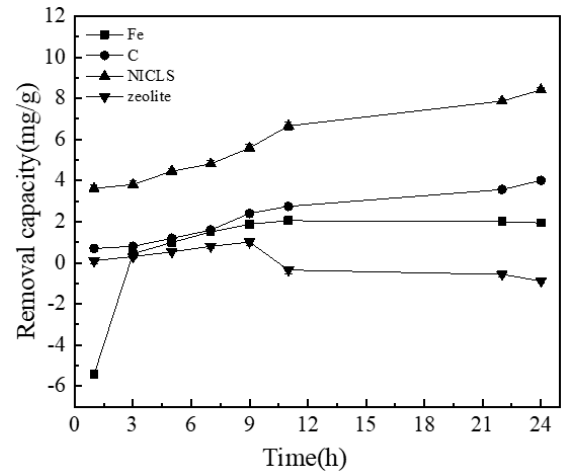
Figure 5. Comparison of the phosphorus removal e ff ects of NICLS, coated iron, coated carbon, and uncoated zeolite (activated carbon is wood activated carbon).